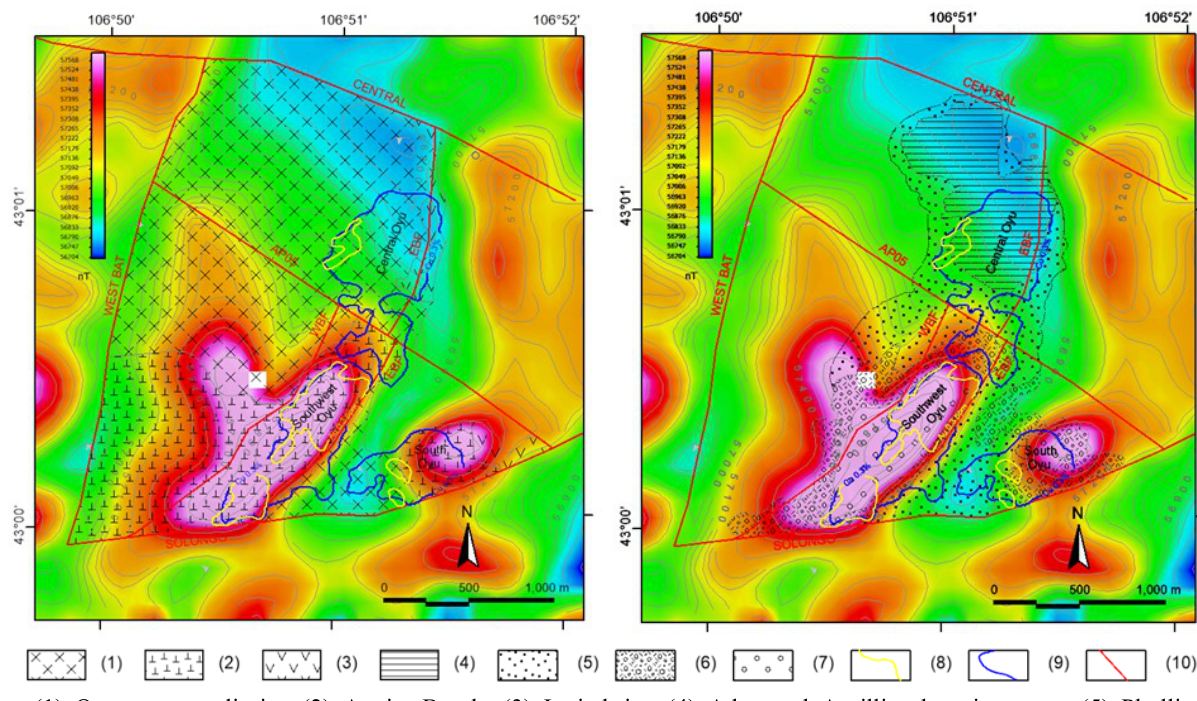
Fig. 6. Reduced to Magnetic Pole Map: The RTP overlapping with lithology (left), RTP overlapping with alteration zones